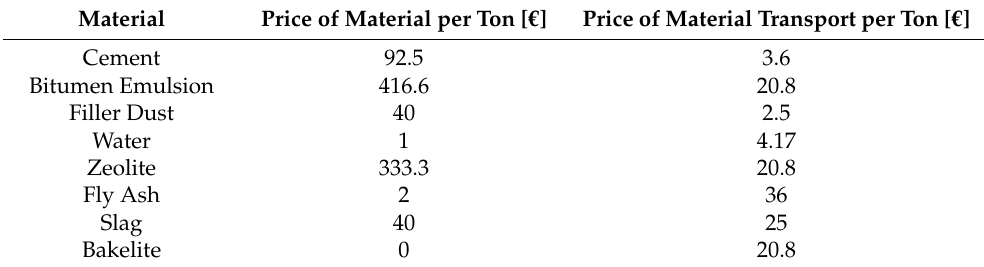
Table 8. Price of materials per ton and price of material transport.